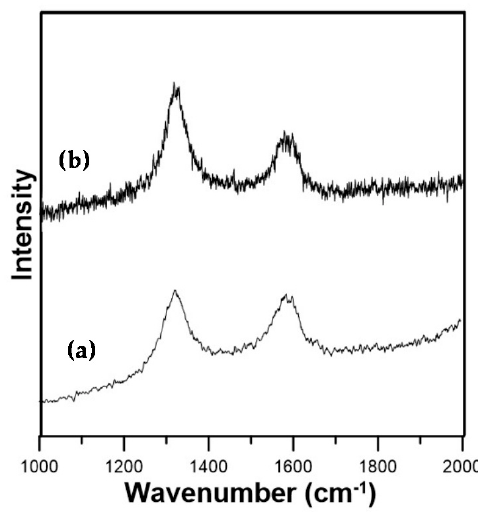
Figure 5. Raman spectra of MWCNTs: ( a ) crude MWCNT; ( b ) carboxylic acid-modified MWCNT-grafted silica nanohybrids.